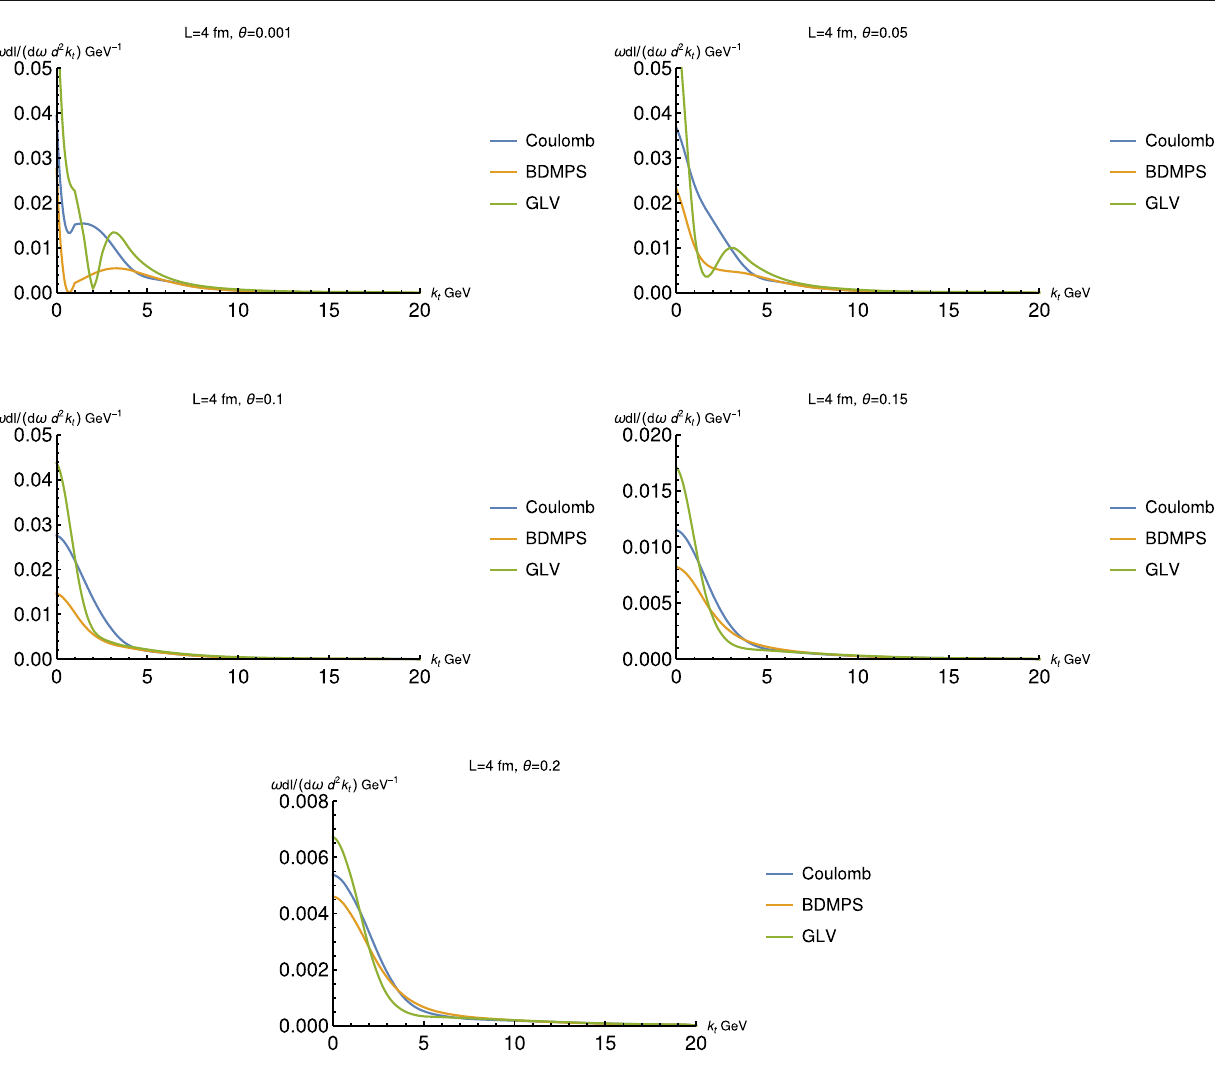
Fig. 3 The angular distribution of radiated gluons for ω = 20 GeV for different θ = 0 , 0 . 05 , 0 . 1 , 0 . 15 , 0 .